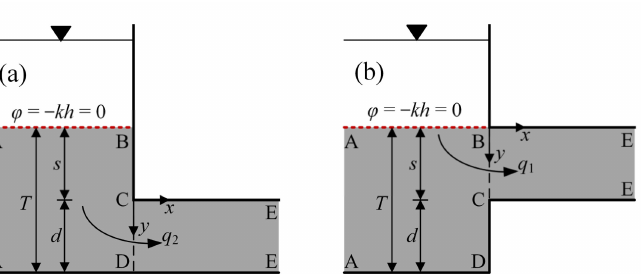
Figure 3. ( a , b ) are the approximate models of the exact models in Figures 2a and 2c, respectively, when w / d and w’ / s are sufficiently large.